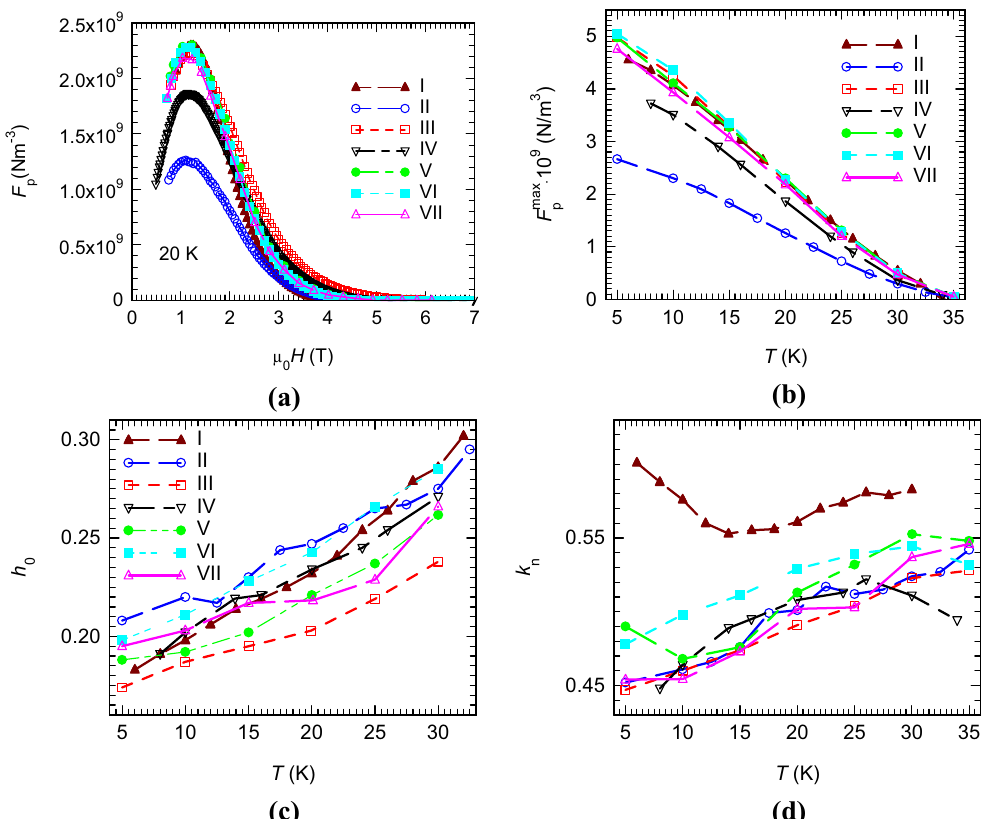
Figure 6. ( a ) The pinning force versus applied magnetic field at 20 K; ( b ) the maximum pinning force vs. temperature; ( c ) the reduced magnetic field for maximum pinning force as function of temperature; ( d ) pinning-force-related parameter k n as a function of temperature. The samples notation is as given in Table 1 (I is the pristine sample and II–VII the added